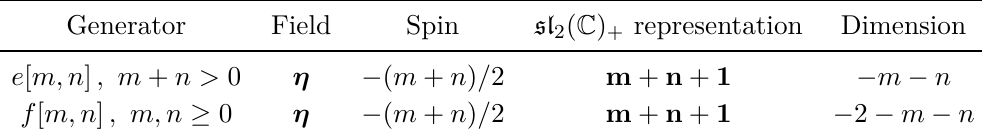
Table 2 . Quantum numbers of e, f